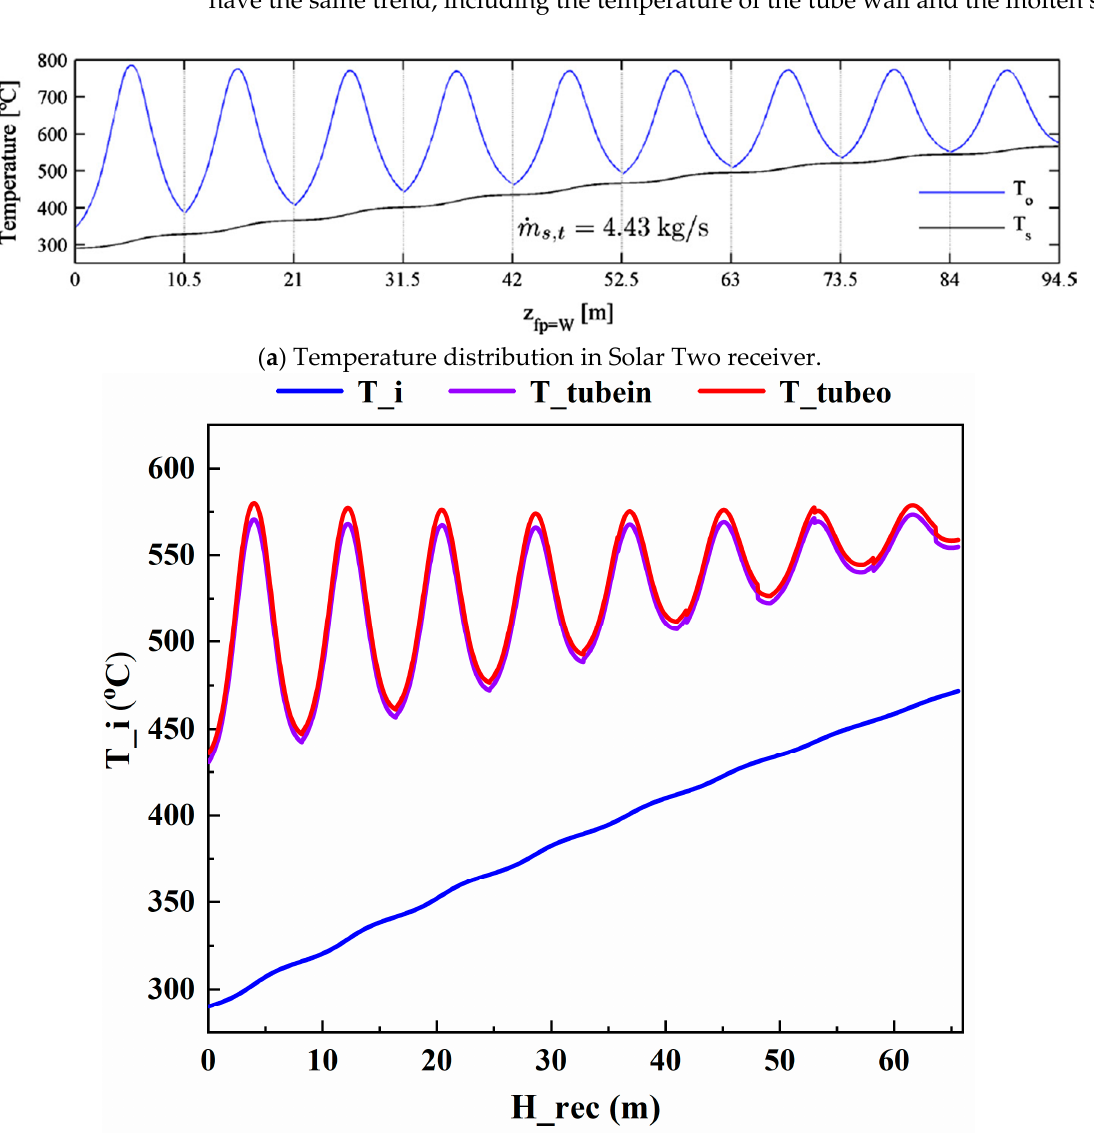
Figure 4. Validation of temperature distribution along the flow direction.